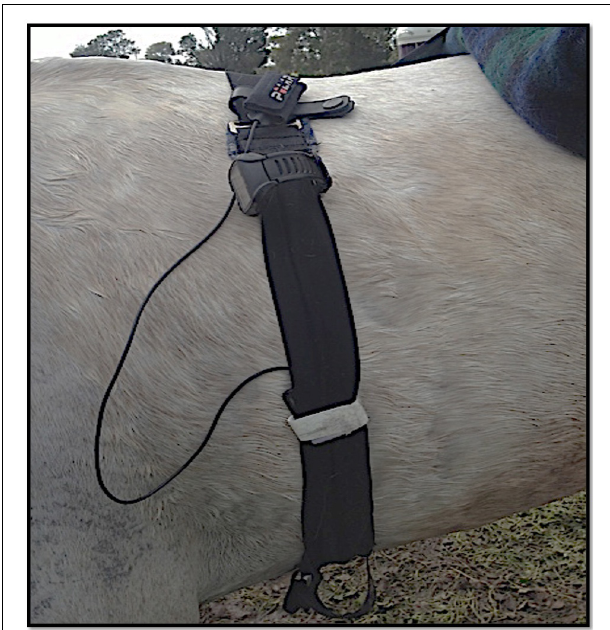
FIGURE 2 | Monitoring equipment: A modified Equivital belt for use on horses with the external receiver device (Sensor Electronics Module) located inside of the belt at of the ventral part of the thorax to monitor the Tc by GI pill, while the Garmin GPS watch and the Polar heartrate electrodes were attached at the upper part of the